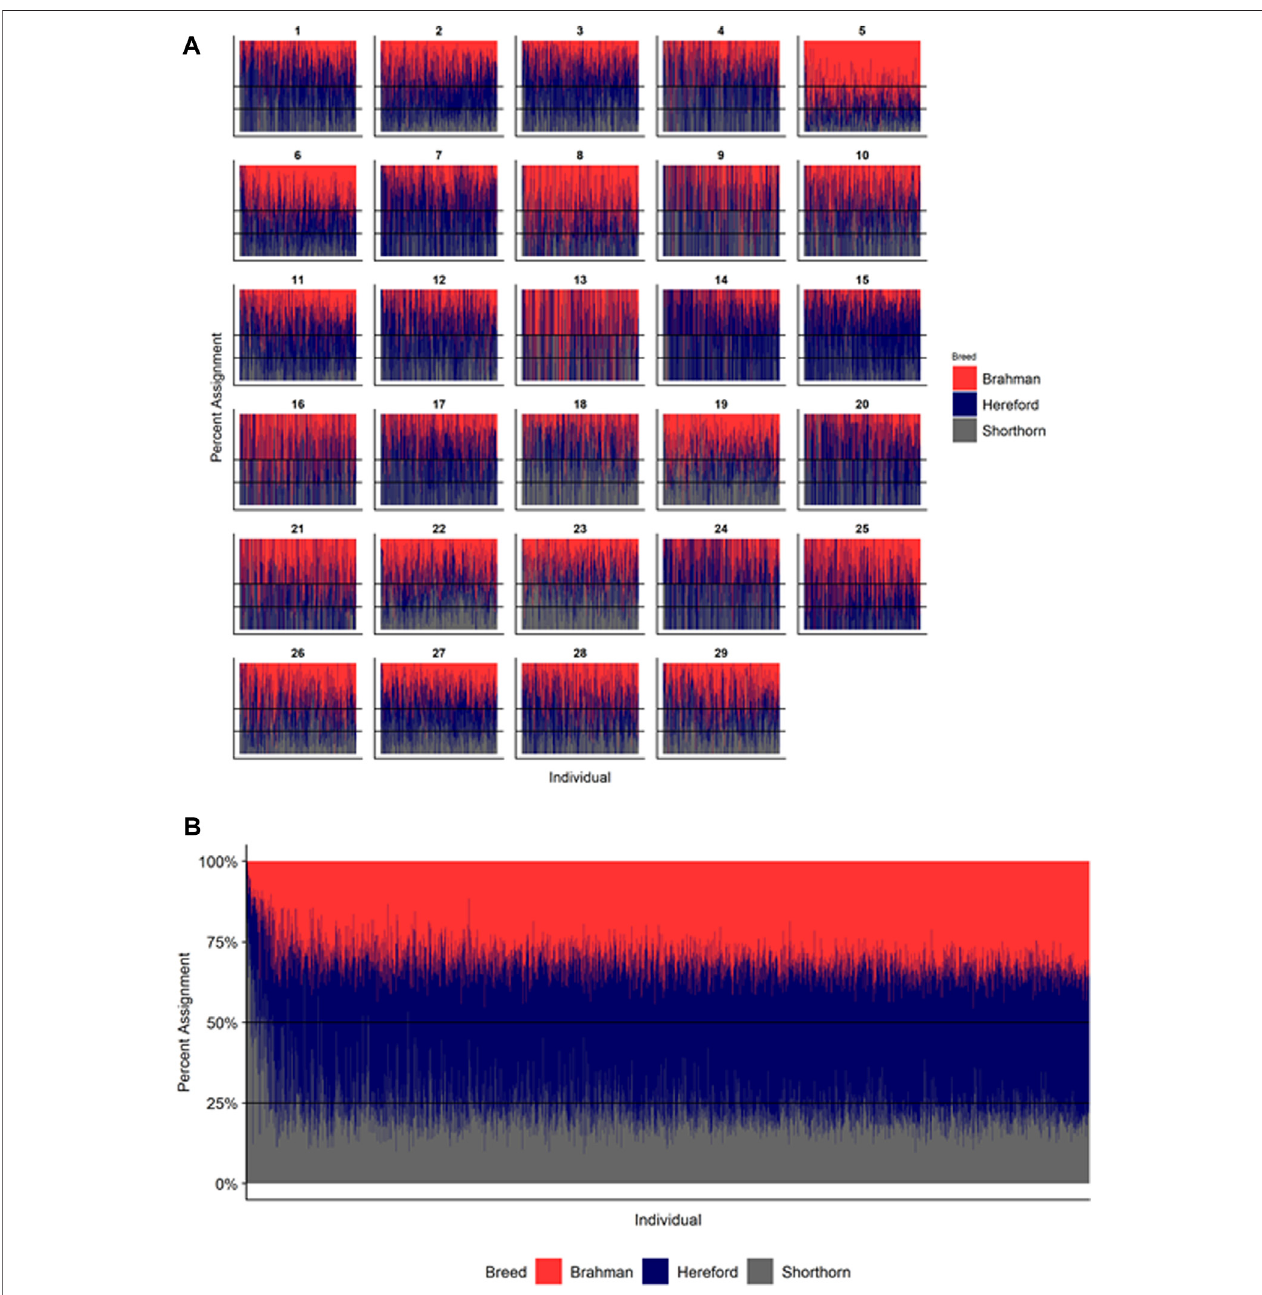
FIGURE 6 | Ancestry estimated by RFMix for each Beefmaster individual plotted with animals sorted by total number of haplotypes. (A) Ancestry assignment for each chromosome, and (B) Genome-wide ancestry. Individuals are represented by vertical bars within each plot with Brahman proportion in red, Hereford in navy, and Shorthorn proportion in gray. Animals to the left on the X -axes have the fewest number of haplotypes predicted within their genomes.